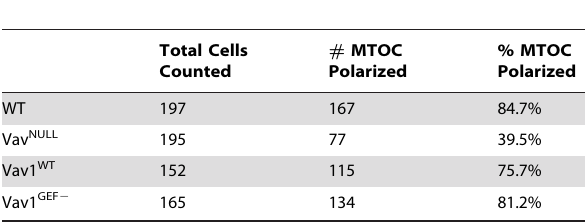
Table 2. TCR-induced MTOC polarization in T cells activated on stimulatory